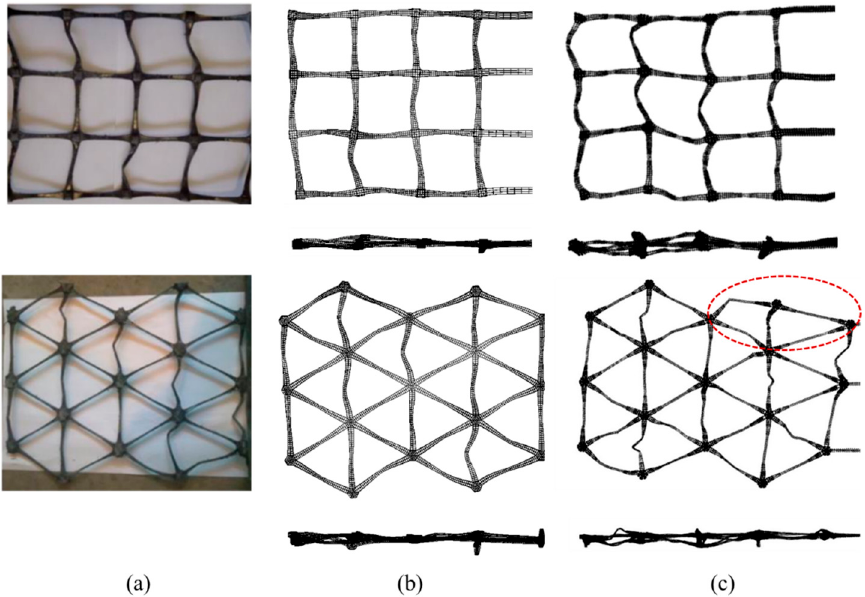
Figure 10. Deformation behavior of biaxial and triaxial geogrid: ( a ) geogrids in experiments; ( b ) geogrids in DEM-FDM model and ( c ) geogrids in DEM model.